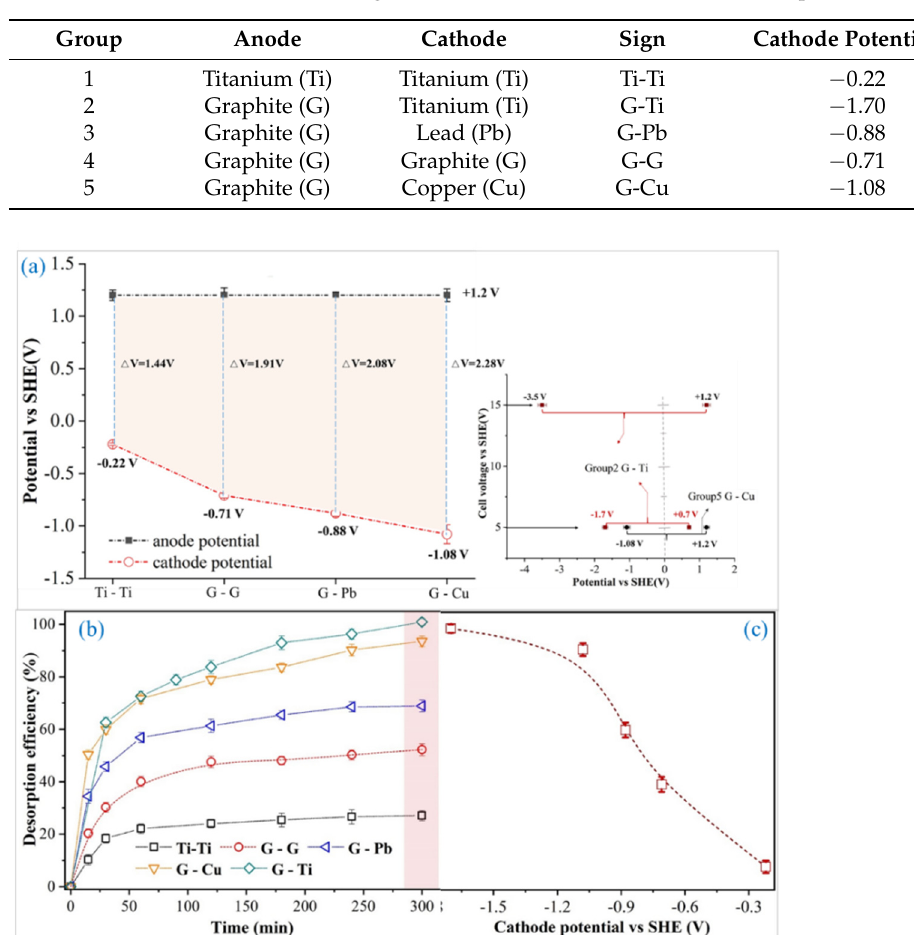
Table 1. The different electrode configurations within the CDI devices for the experiments.